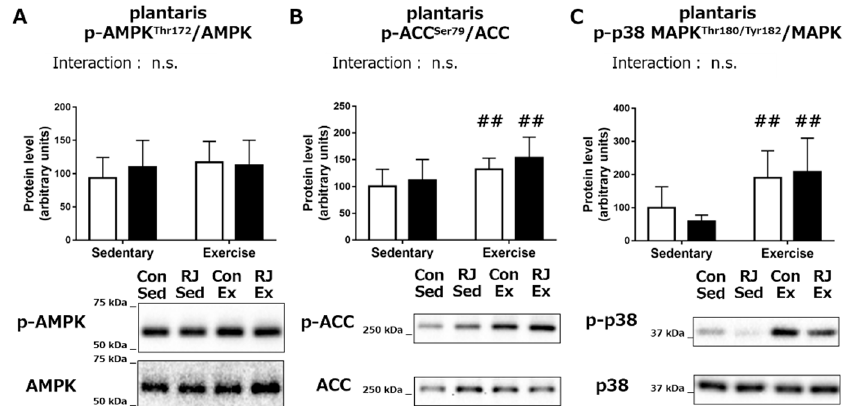
Figure 4. ( A ) AMPK, ( B ) ACC, and ( C ) p38 MAPK phosphorylation status in the plantaris muscle of mice that was treated with a single dose of royal jelly (RJ-treated group; black) or distilled water (Control group; white) and with or without an endurance exercise (Acute experiment). Values represent mean ± standard error. n = 6–7 per group. ## p < 0.01, main effect of endurance exercise. n.s.: not significant.